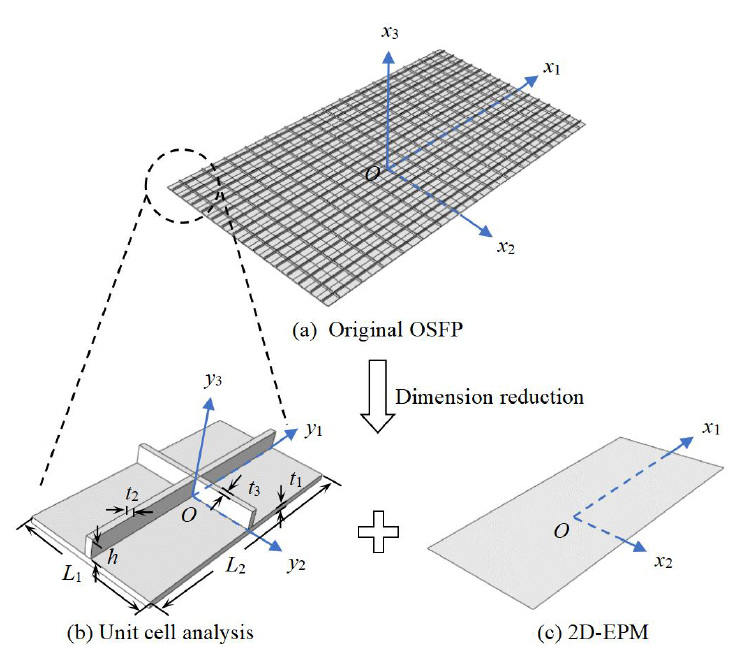
Figure 1. Dimension reduction analysis of the original orthogrid-stiffened FRP panel